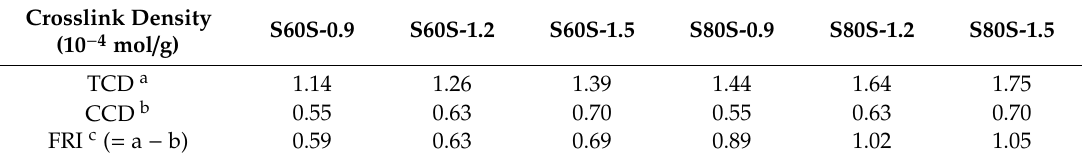
Table 4. Crosslink density of various vulcanizates.